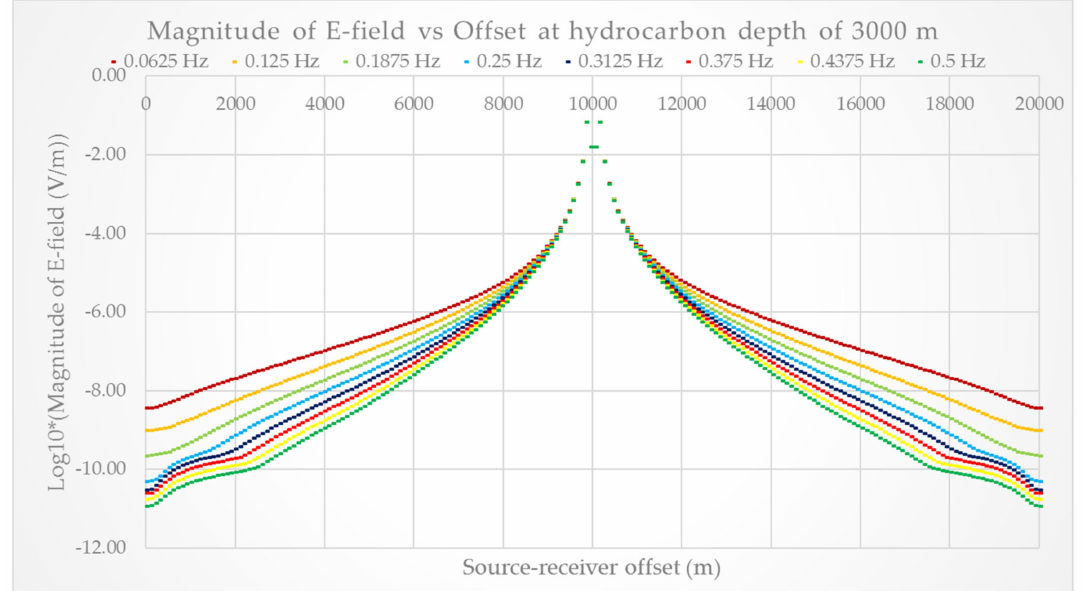
Figure 5. EM responses obtained from the target models, where the hydrocarbon layer was located at 3000 m from the seabed, for multiple frequencies (0.0625–0.5 Hz with an increment of 0.0625 Hz each). The total source-receiver separation distance is 20,000